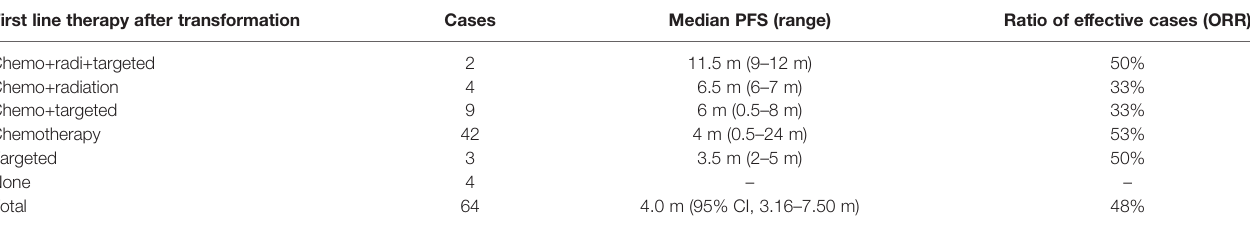
TABLE 2 | First-line treatment and ef fi